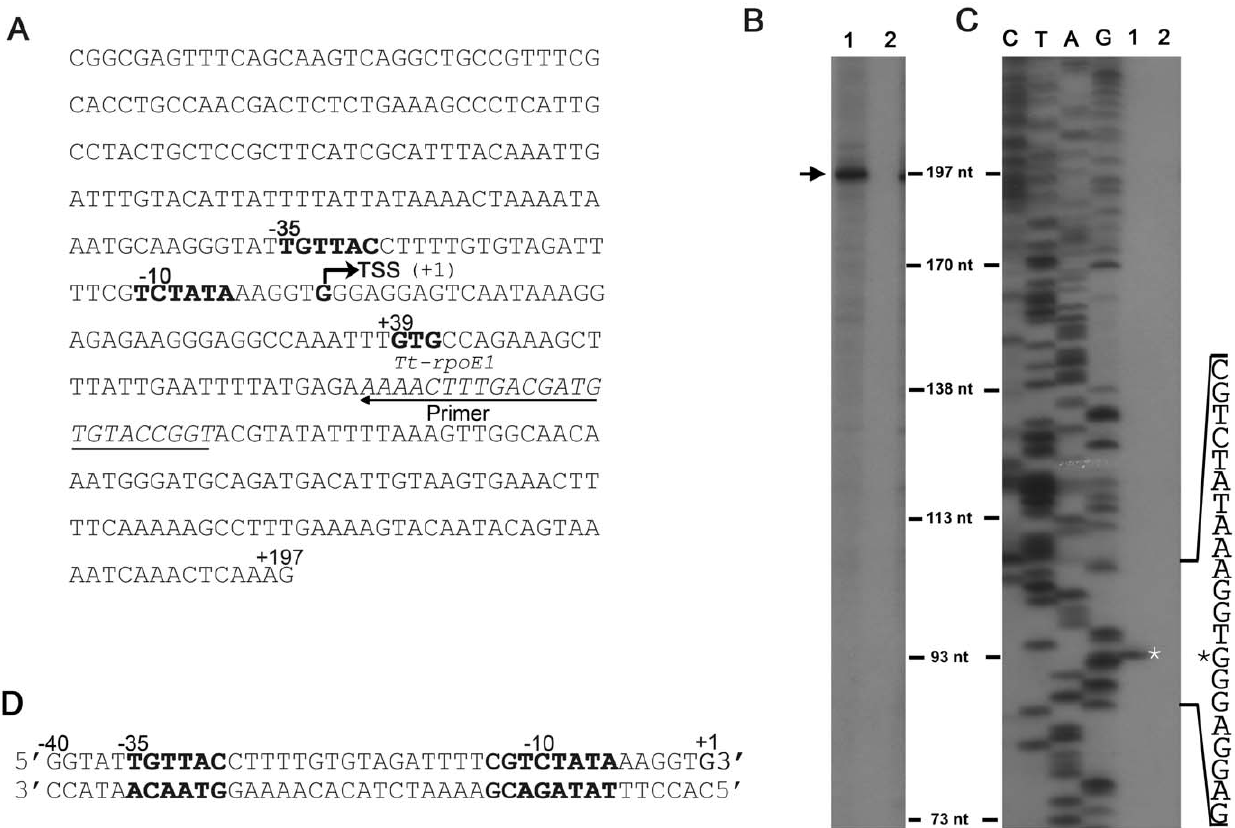
Figure 2. Analysis of Tt-RpoE1 recognition of its own promoter sequence by invitro transcription and primer extension assays. ( A ). Sequence of the in vitro run-off transcription which includes 218 bp upstream and 159 bp of Tt-rpoE1 gene. ( B ). In vitro run-off transcription of Tt- rpoE1 template ( A ) by E. coli core RNAP with (lane 1) or without (lane 2) Tt-RpoE1. The transcription product is indicated with an arrow. ( C ). Mapping of the transcriptional start site (TSS) of Tt-rpoE1 by primer extension, in which RNA was isolated from in vitro transcription reactions with (lane 1) or without (lane 2) Tt-RpoE1. The TSS is marked by an asterisk. Lanes C, T, A, and G are the DNA sequencing ladder corresponding to the primer extension results. The relevant sequence is shown at the side. The Tt-rpoE1 promoter region (the deduced 2 10 and 2 35 regions), the TSS and the putative translation start codon ( + 39) are all indicated in ( A ). The position of the primer used for primer extension and DNA sequencing is underlined. ( D ). Sequence of the double-stranded parental probe for the following EMSA assay.